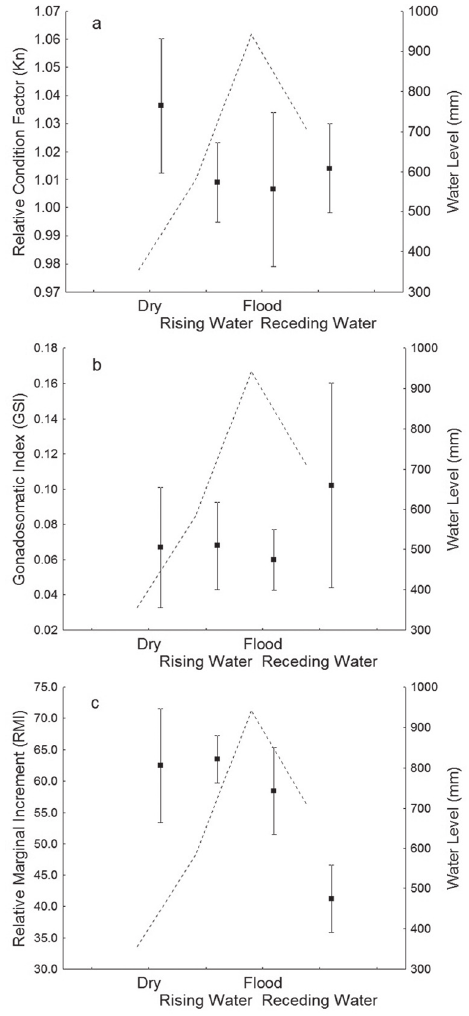
Fig. 4. Variation in the condition factor (a), gonadosomatic index (b), and marginal relative increment (c) of Cichla temensis according to hydrological period and the water level of the middle rio Negro between October 2011 and September 2012.